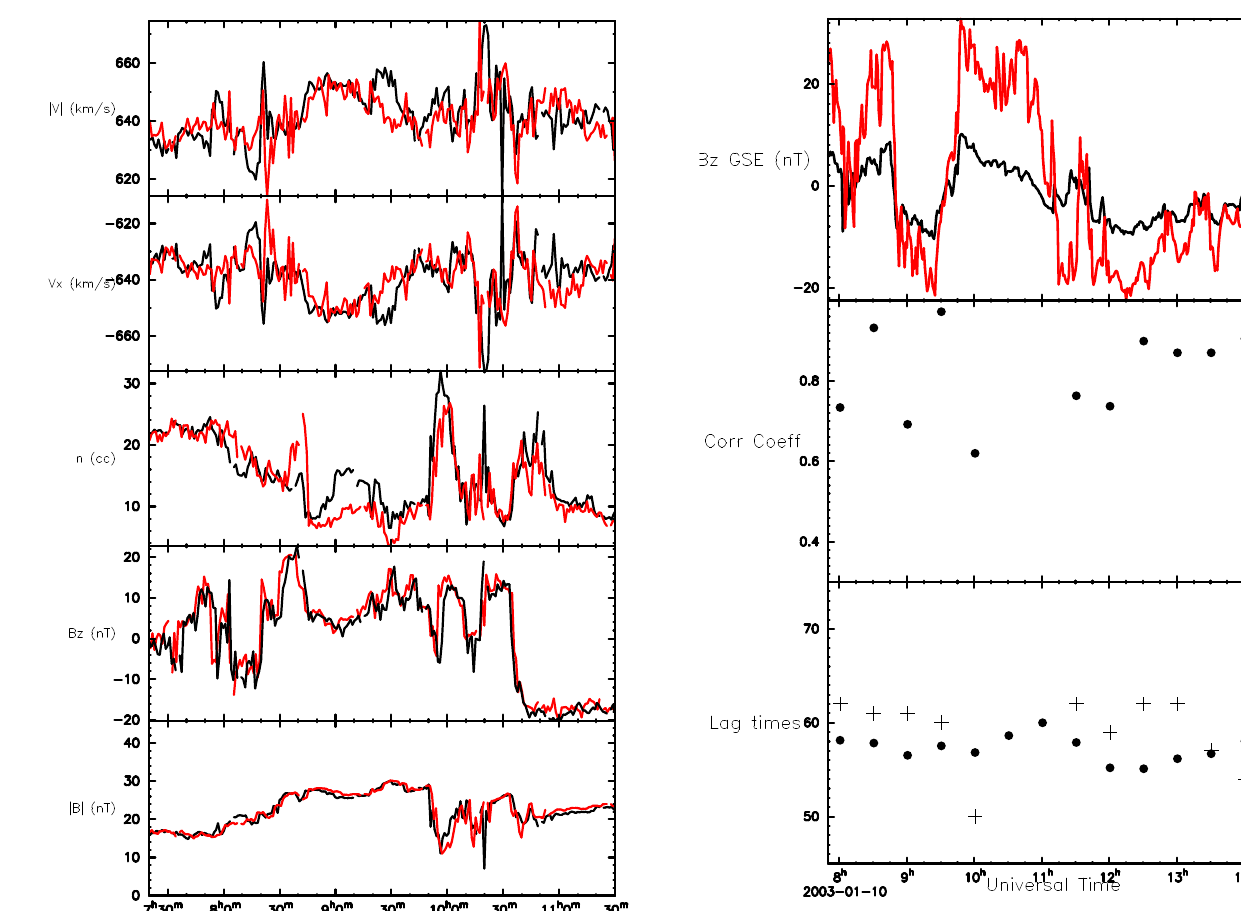
Fig. 3. Intercalibration of the Cluster and Ace data sets: A com- parison of ACE solar wind (red) and Cluster 1 (black), ion velocity, ion density and magnetic field data on the 22nd of January 2004. The ACE data has been time shifted by 37min, corresponding to a solar wind velocity, V sw ≈ 650kms − 1 for illustrative purposes and shows excellent agreement with the Cluster measurements.